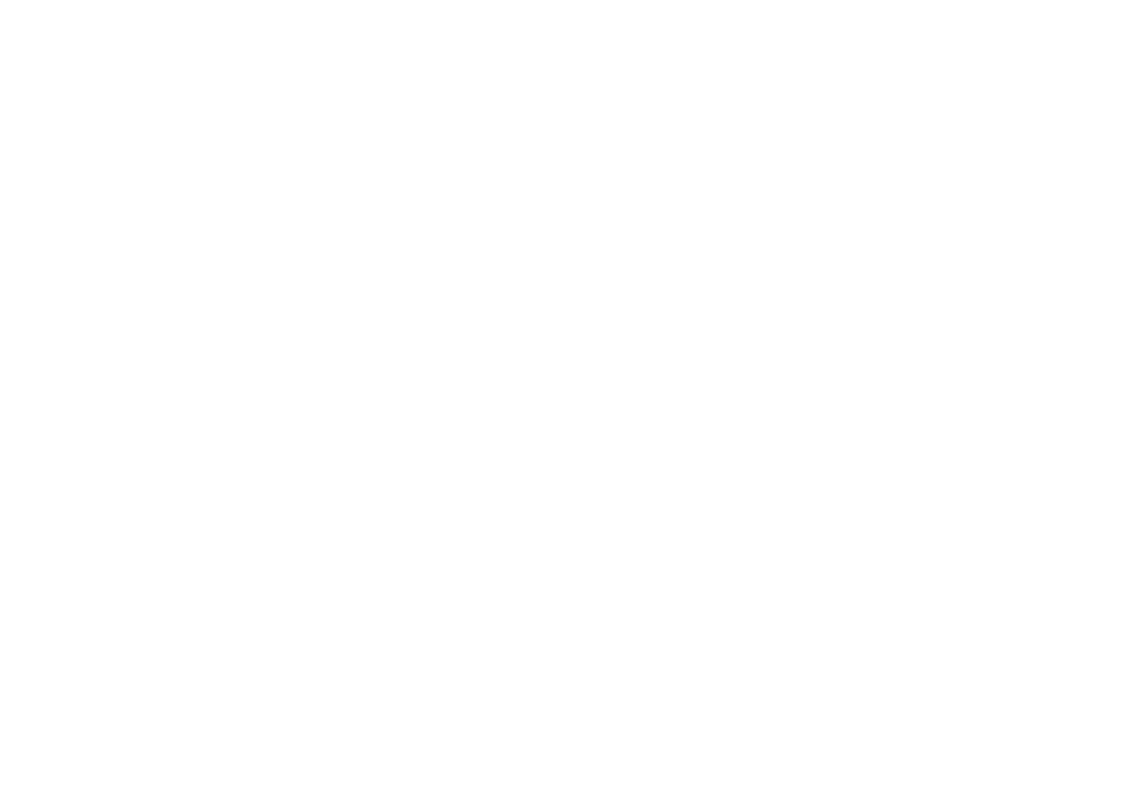
Figure 5. ( a ) F ′ (ξ) , ( b ) G (ξ) and ( c ) θ(ξ) with diverse m